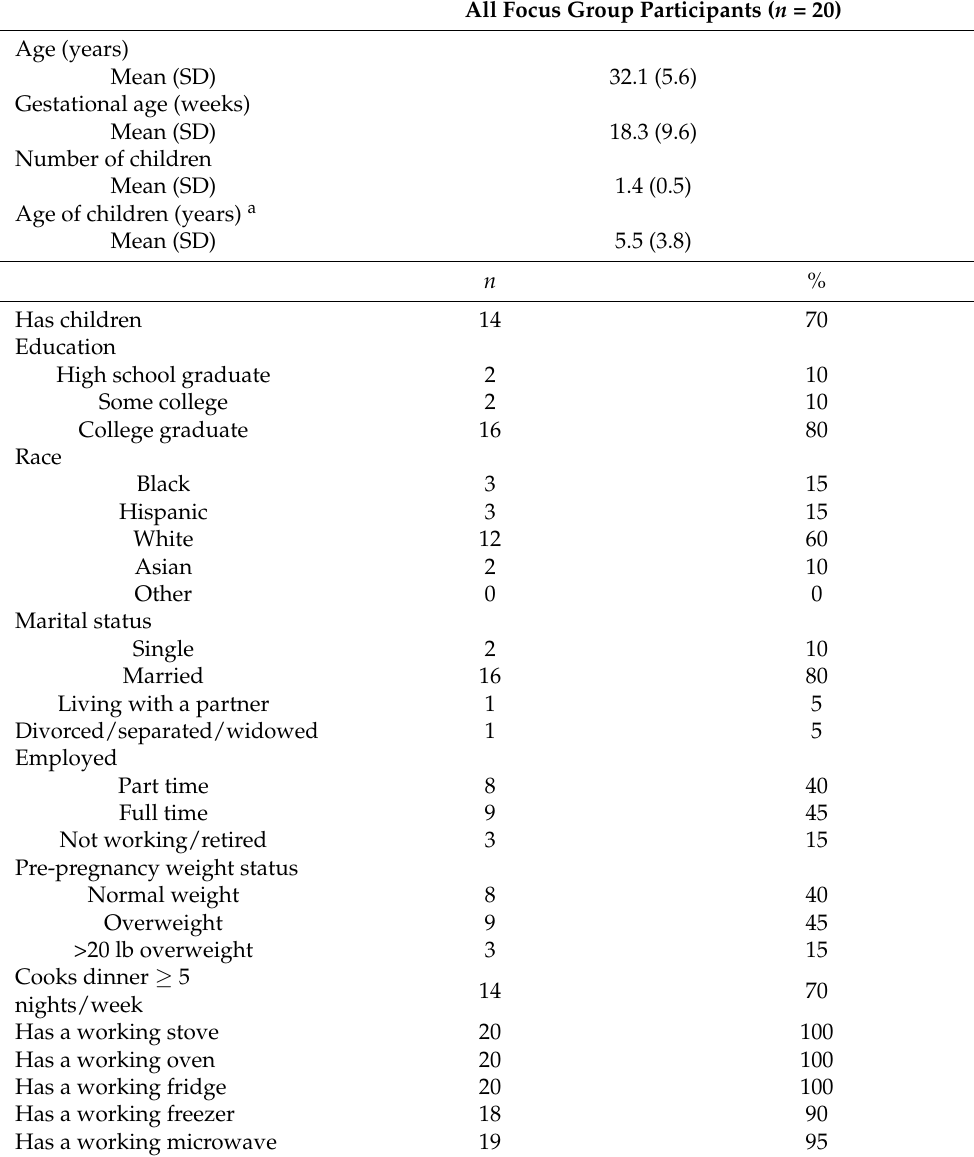
Table 1. Demographic characteristics of focus group